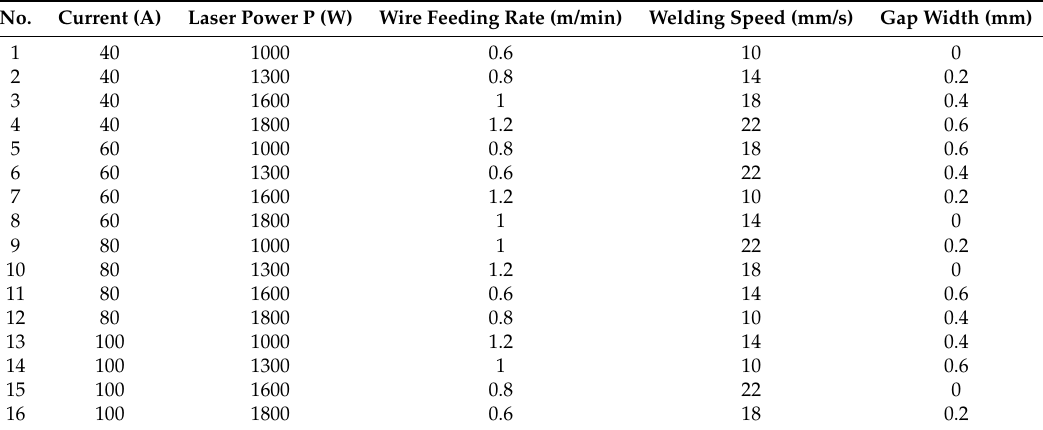
Table 2. Standard orthogonal test table.